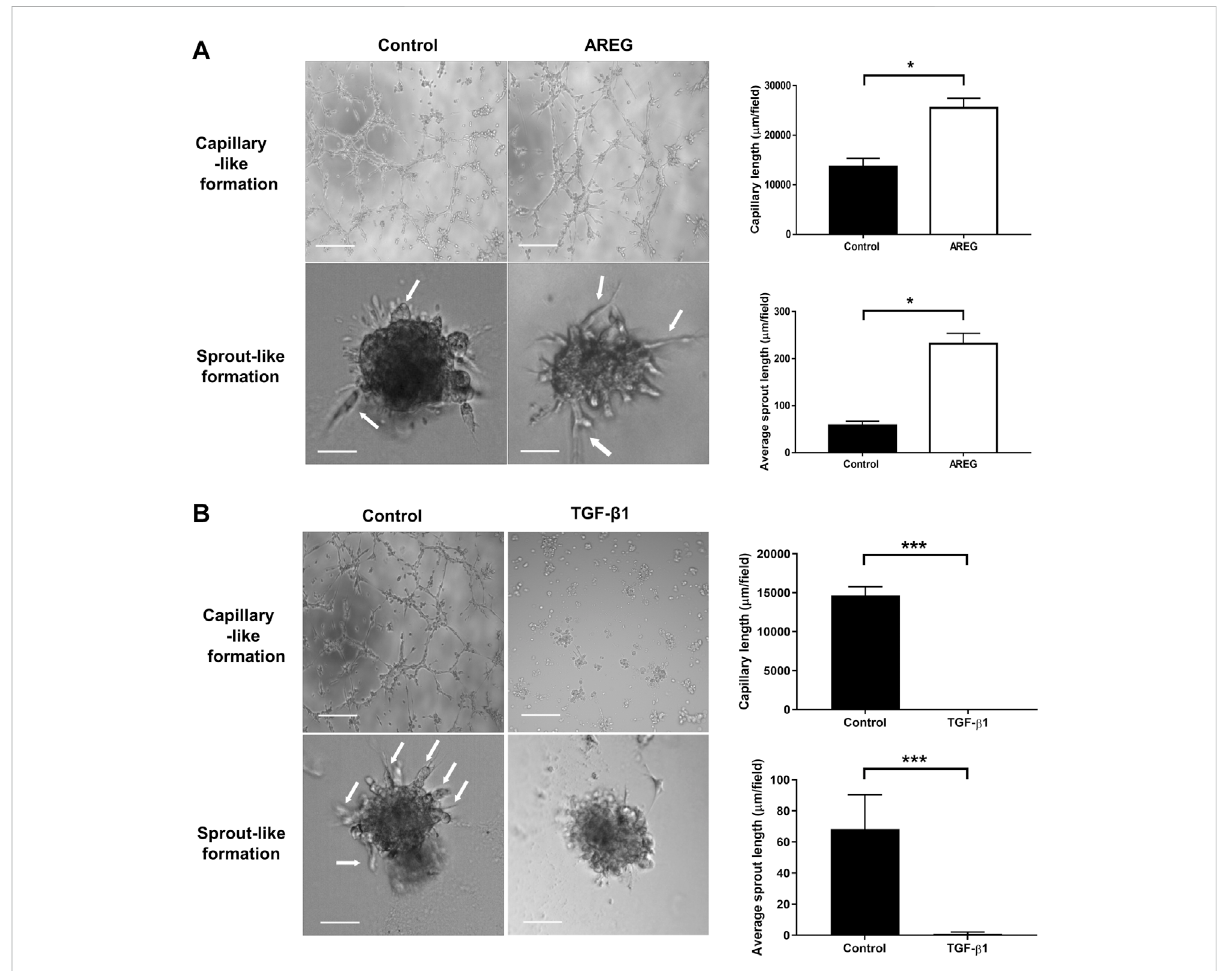
FIGURE 2 Effects of AREG and TGF- β 1 on microvasculature-like formation in SVOG cells. Cells were pretreated with a vehicle control, AREG (100 ng/ml) (A) or TGF- β 1 (10 ng/ml) (B) for 24 h. The cells were transferred to Matrigel for further 5 h (for capillary-like formation) and 24 h (for sprout-like formation).Scalebarsofthecapillary-likeformationandsprout-likeformationrepresent100 µmand50 μ m,respectively.Theaveragelengthsofthe capillaries and sprouts were quanti fi ed by ImageJ. Values labeled with different letters are signi fi cantly different ( p < 0.05), n =